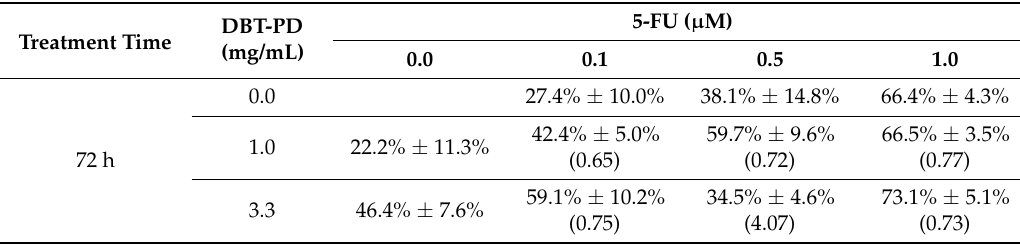
Table 5. Percent growth inhibition and combination index (CI) of HT-29 cells treated with DBT-PD and different concentrations of 5-FU.